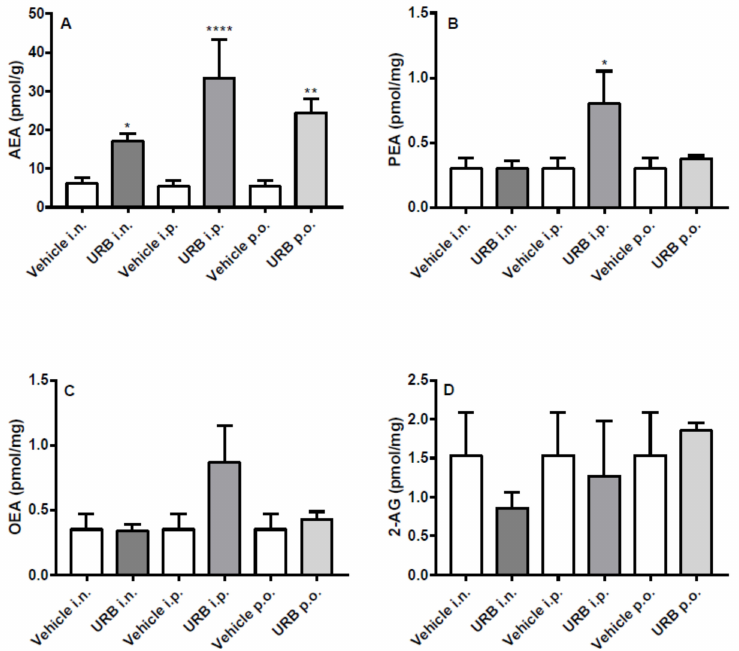
Figure 6. E ff ect of in vivo URB administration on liver levels of NAEs and 2-AG. Levels of ( A ) AEA, ( B ) PEA, ( C ) OEA and ( D ) 2-AG following URB or vehicle (i.n., i.p. or p.o.) administration. Data are presented as mean ± SEM expressed as pmol per gram or milligram of wet tissue. * p < 0.05, ** p < 0.01 and **** p < 0.0001 post hoc comparisons with vehicle conditions, Tukey’s